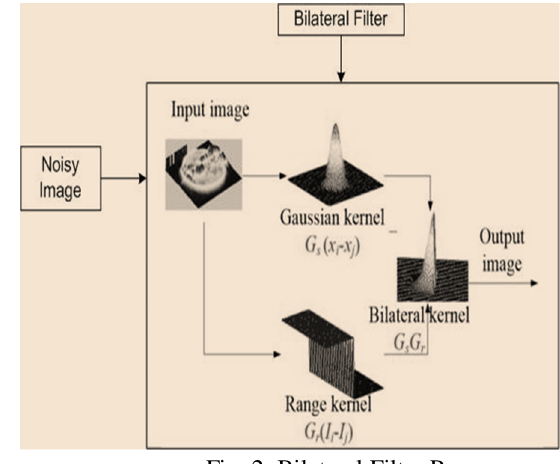
Fig. 2: Bilateral Filter